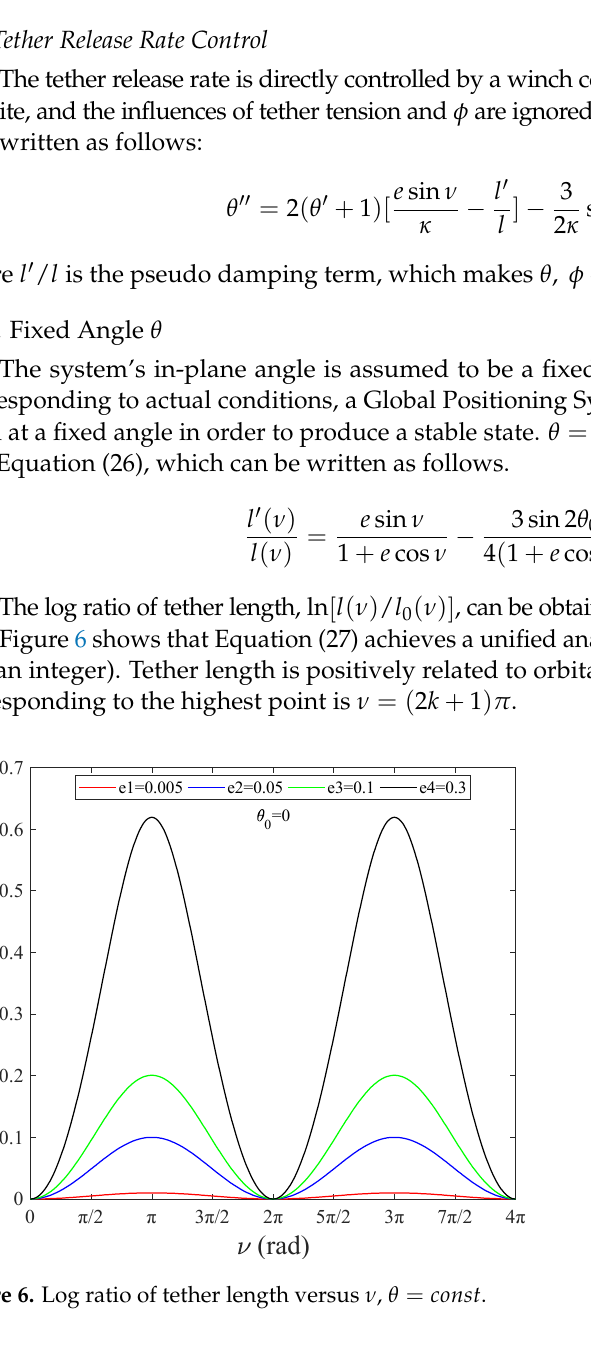
Figure 6. Log ratio of tether length versus